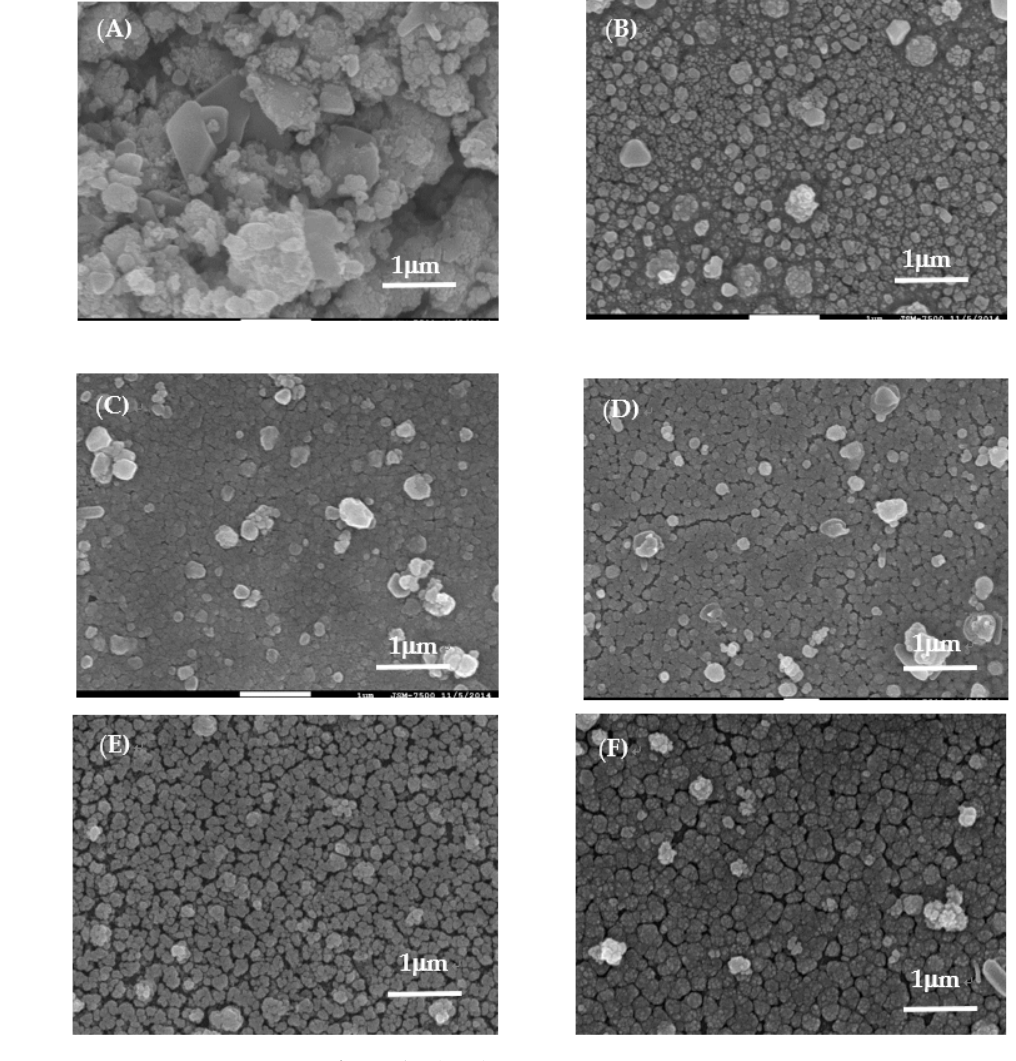
Figure 2. FE-SEM images of samples ( A – F ). With the [Zn]/[Sn] molar ratio kept at 0.2 in the precursor solution (sample C), the surface microstructures became irregular spherical grains. The plate-like microstructures almost disappeared due to the formation of certain amount for Ag 2 ZnSnS 4 phase with the orientation (1 1 2) crystal plane, as shown in Figure 1. The microstructure of sample C was the same as those of the Ag 2 ZnSnS 4 powders reported by Li et al. (2013) [13] and Liang et al. (2019) [25]. With the Zn content in samples further increasing (samples D–F), the mi- crostructures at sample surface were irregular spherical grains. Some pinholes and cracks were also observed in samples E and F. The thicknesses of the samples obtained from surface profile measurements are 1.8 ± 0.1 μ m.